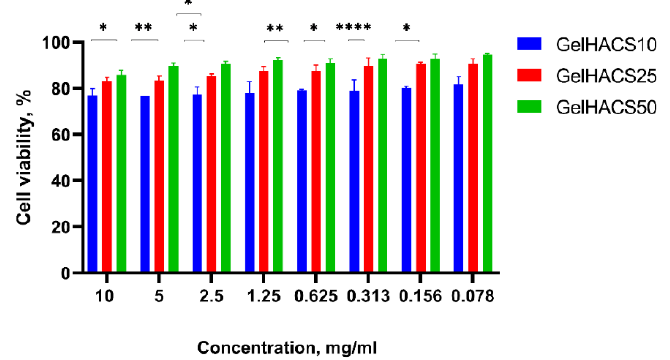
Figure 7. Effects of GelHACS extracts on viability of rat ADMSC presented as percentage of cell viability versus concentration of the extracts. The experiments were repeated in triplicate independently, and the data are expressed as the means ± SD with * p < 0.05; ** p < 0.01; **** p < 0.0001.